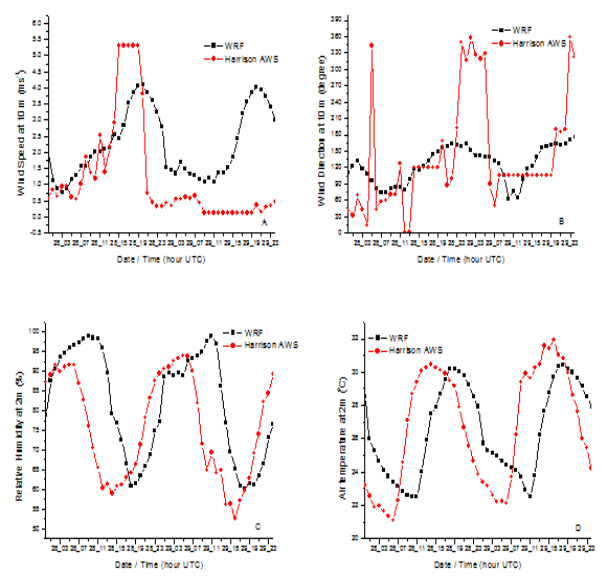
Figure 13 : Simulated and observed 10 m wind speed (A), 10 m wind direction (B), 2m relative humidity (C) and 2m air temperature (D) for the model grid at Harrison site from 18:00 LT June 28- 18:00 LT, June 30.